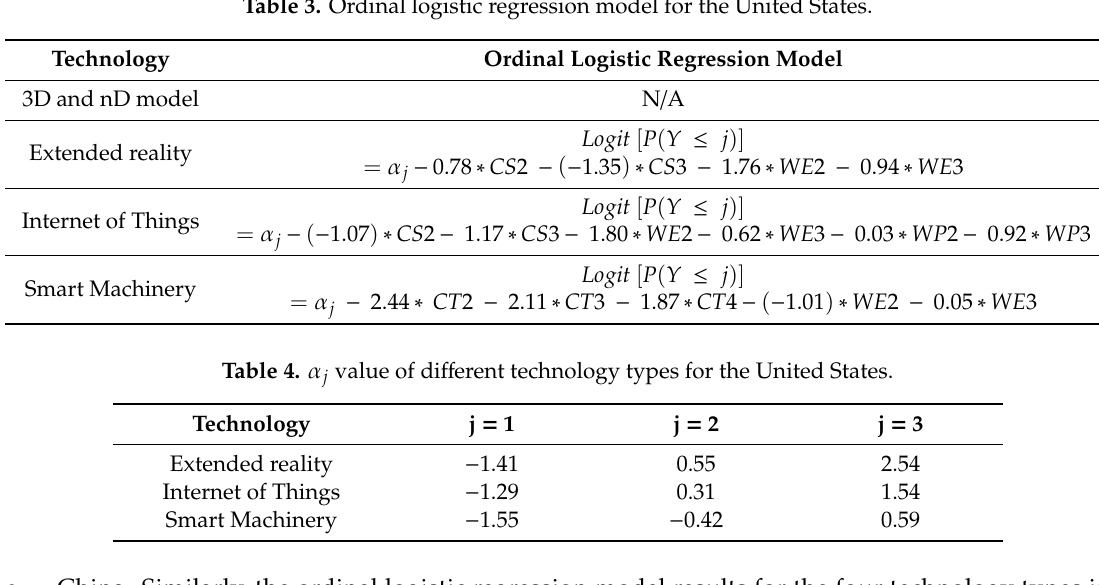
Table 3. Ordinal logistic regression model for the United States.